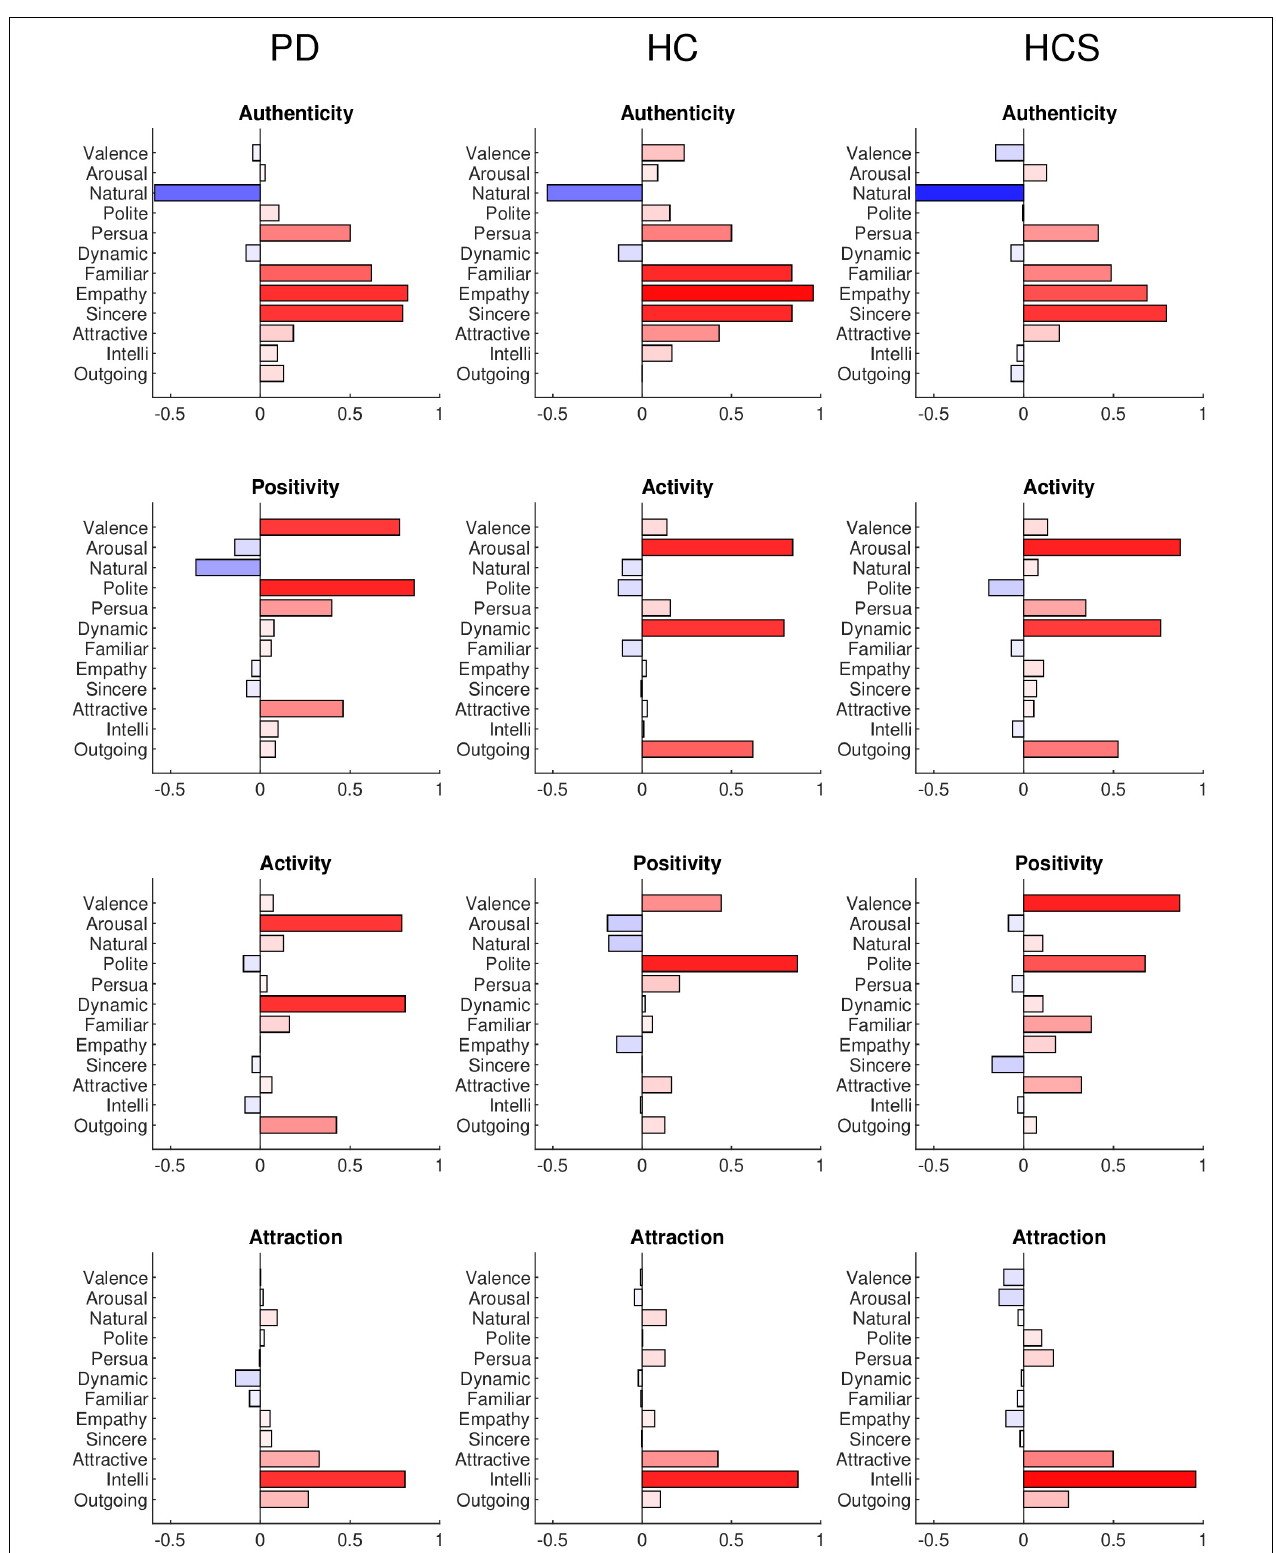
FIGURE 3 | Factor analysis results for the PD, HC, and HCS groups for all 12 dimensions. Each loading is plotted as positive (red) or negative (blue) with color saturation indicating the strength of the loading.